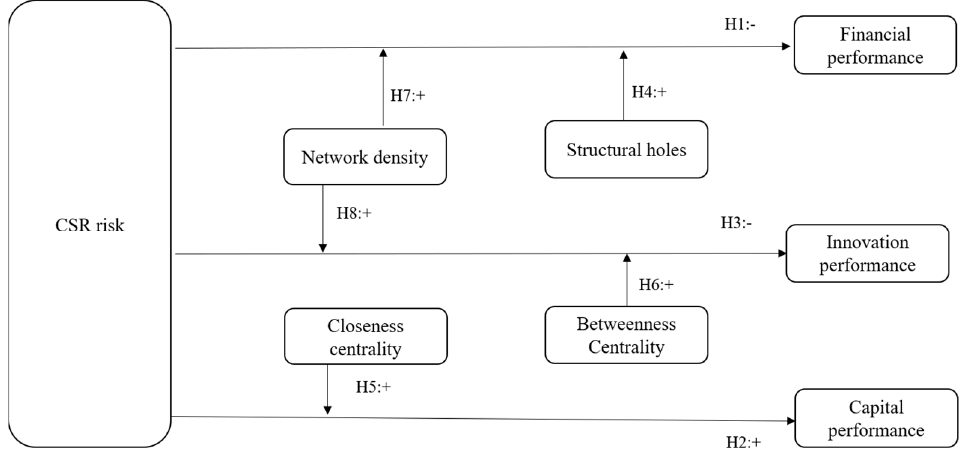
Figure 1. The conceptual framework. The conceptual framework clearly articulates the hypothesis of the relationship between CSR risk and firm performance and the moderating effect of different network variables on their relationship.